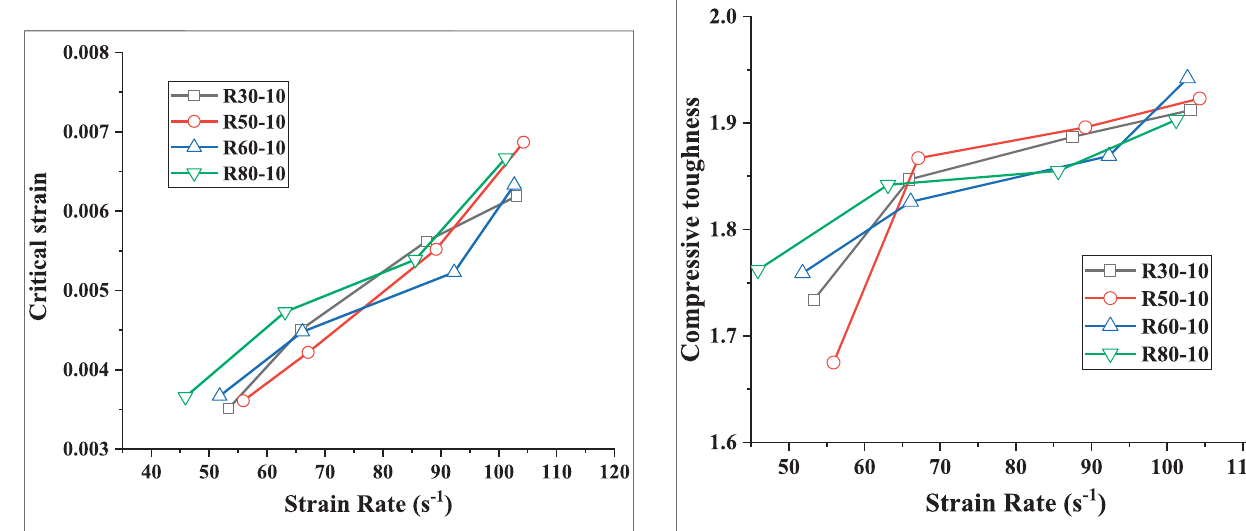
FIGURE 20 | Compressive toughness of mortar with different rubber particle